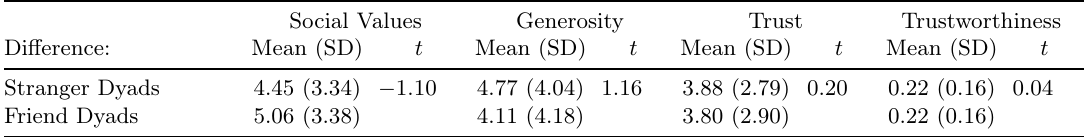
Table 3: Absolute Differences Between Friends’ and Strangers’ Respnses for Four Measures of Prosocial Behaviors (Study 3) Social Values Generosity Trust